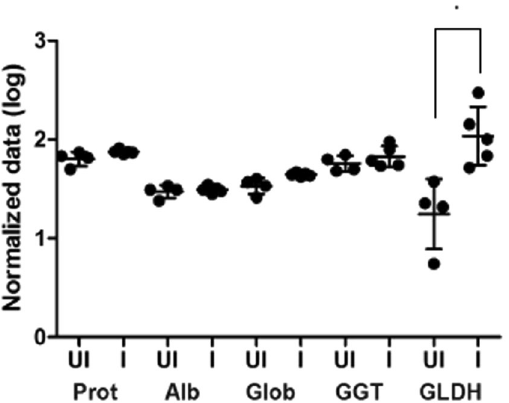
Figure 2. Liver enzyme profile. Serum from uninfected (UI) and infected (I) sheep, representing the mean (n = 5) of each group ± standard deviation were analysed for a variety of liver enzymes. The normalised data is shown by a dot plot on a log scale. Prot: total protein (g/l); Alb: albumin (g/l); Glob: globulin (g/l); GGT: gamma glutamyl-transferase (units/l) and GLDH: glutamate dehydrogenase (units/l). * P value =